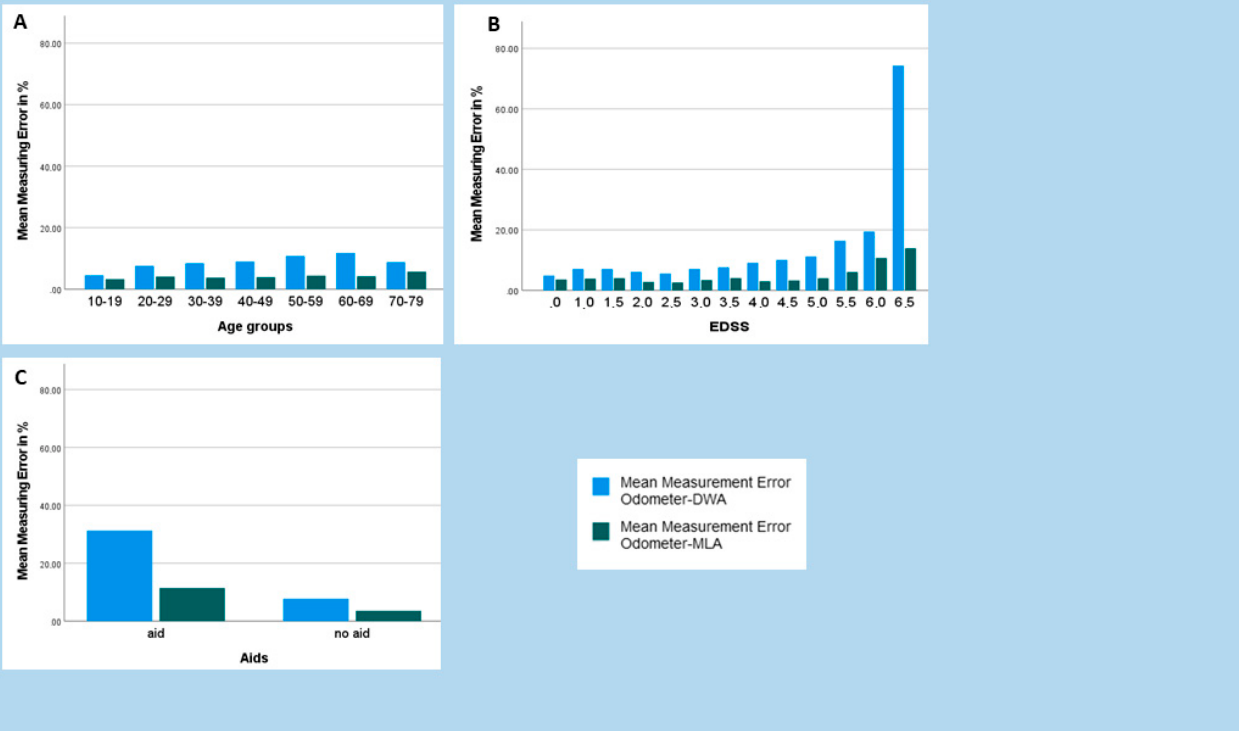
Figure 8. Representation of the relative measurement errors of the Digiwalk algorithm (DWA) and the Mobility Lab algorithm (MLA) in relation to the influence variables of age ( A ), Expanded Disability Status Scale ( B ), and use of aids ( C ).